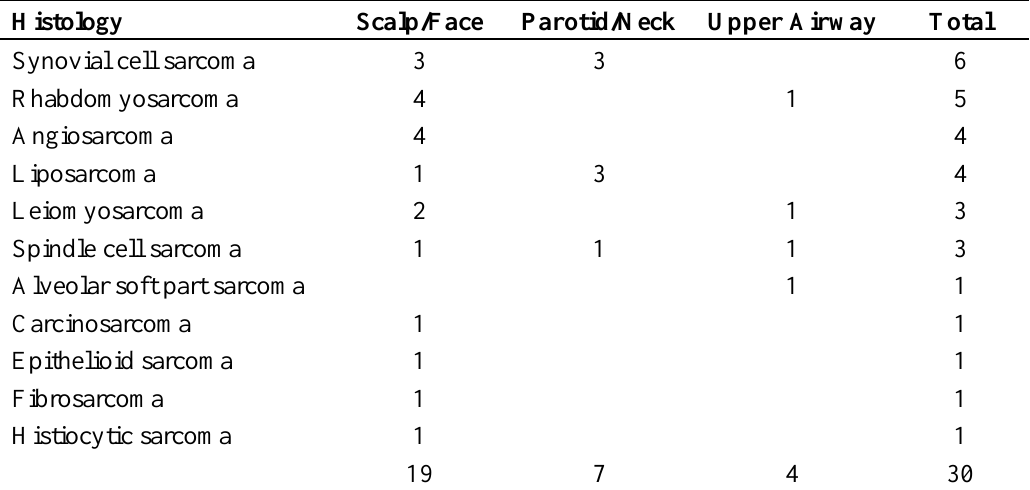
Table 1. Patient distribution according to tumor histology and